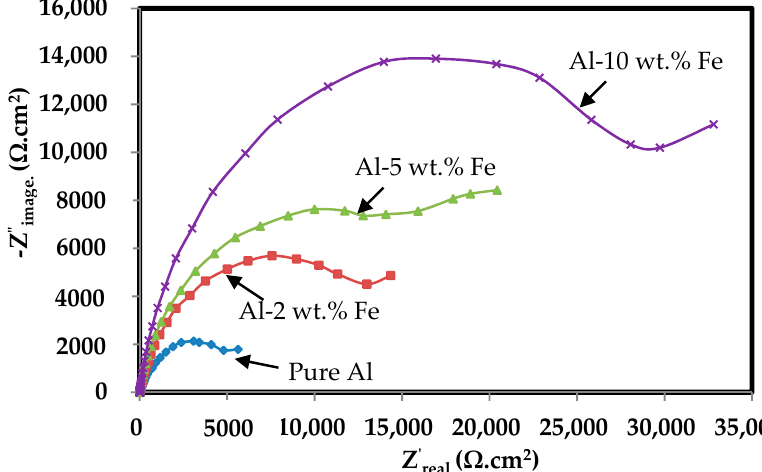
Figure 8. Nyquist plot for pure Al and Al-Fe alloys after one hour of immersion in 3.5% NaCl solution.